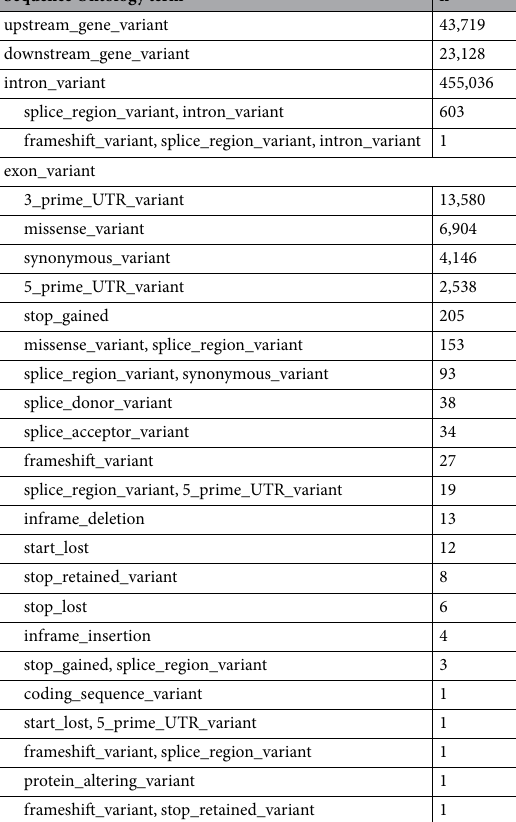
Table 1. Sequence ontology consequence terms for genetic variants in human GT genes.